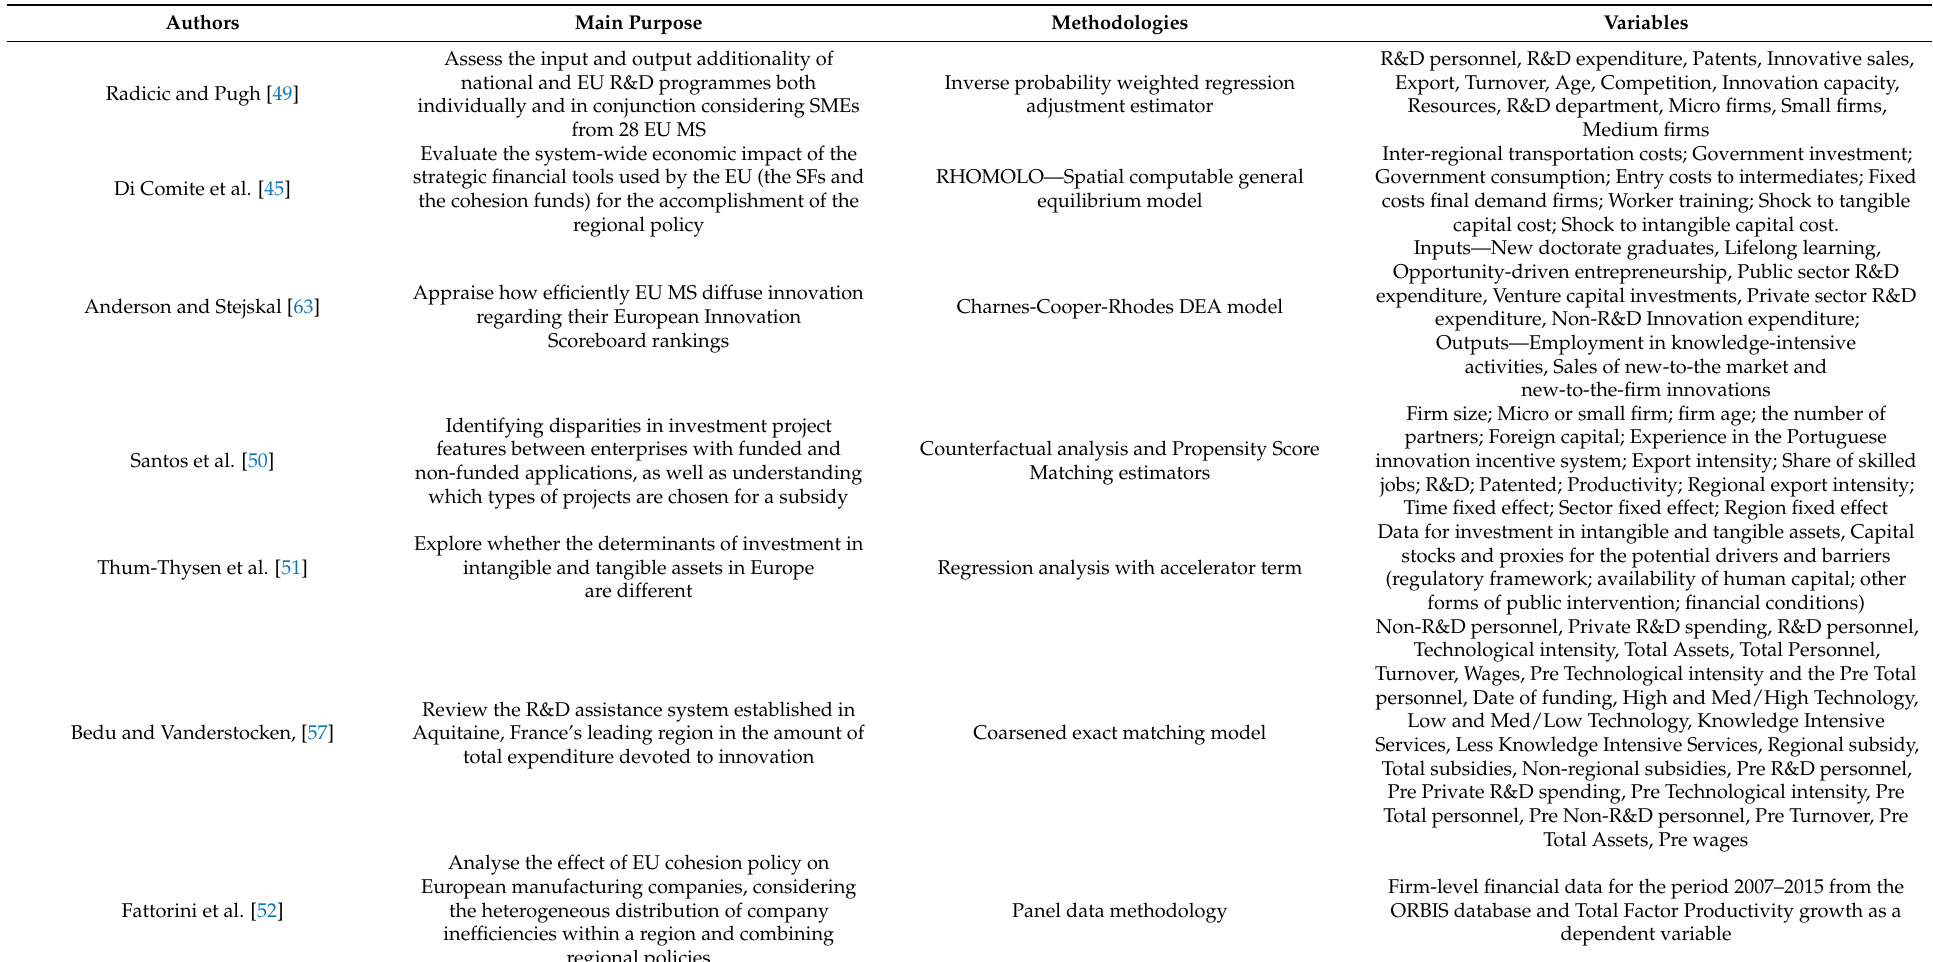
Table 1. Studies on the assessment of